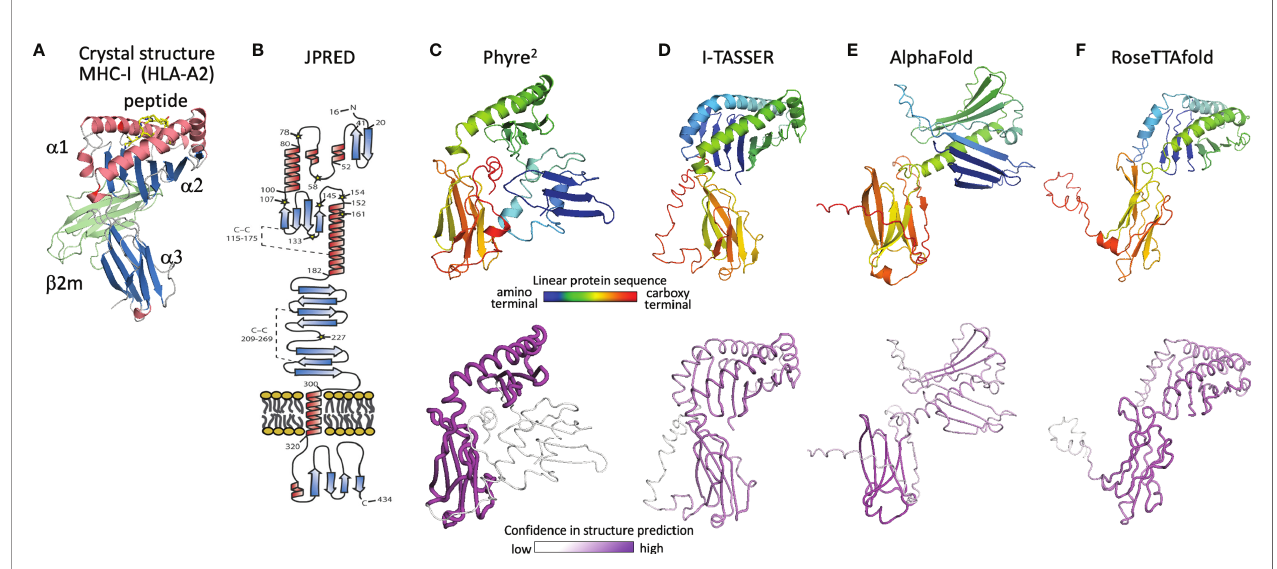
FIGURE 5 | Evolution of U20 structure prediction. (A) Structure of HLA-A2, a classical MHC-Ia protein that adopts the canonical MHC fold. MHC a 1 and a 2 domains in the MHC platform and a 3 immunoglobulin-like domain colored by secondary structure for comparison with panel B, with the MHC-associated non- polymorphic small subunit b 2-microglobulin shown in green and bound peptide shown in yellow. (B) Secondary structure prediction from JPRED (48, 53), fi gure reproduced with permission from reference (48). (C – F) , Three-dimensional structure predictions from (C) , Phyre 2 , (D) , I-TASSER, (E) , AlphaFold, and (F) , RoseTTAfold. Top panels show ribbon diagrams colored by linear protein sequence; bottom panels show tube diagrams colored by modeling con fi